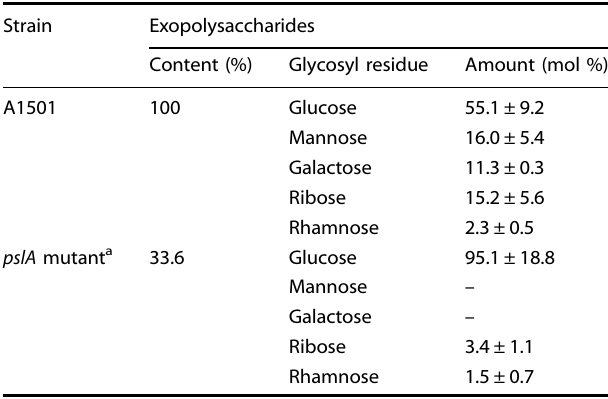
Table 2. Content and carbohydrate monomer composition of the total exopolysaccharides isolated from A1501 and the pslA